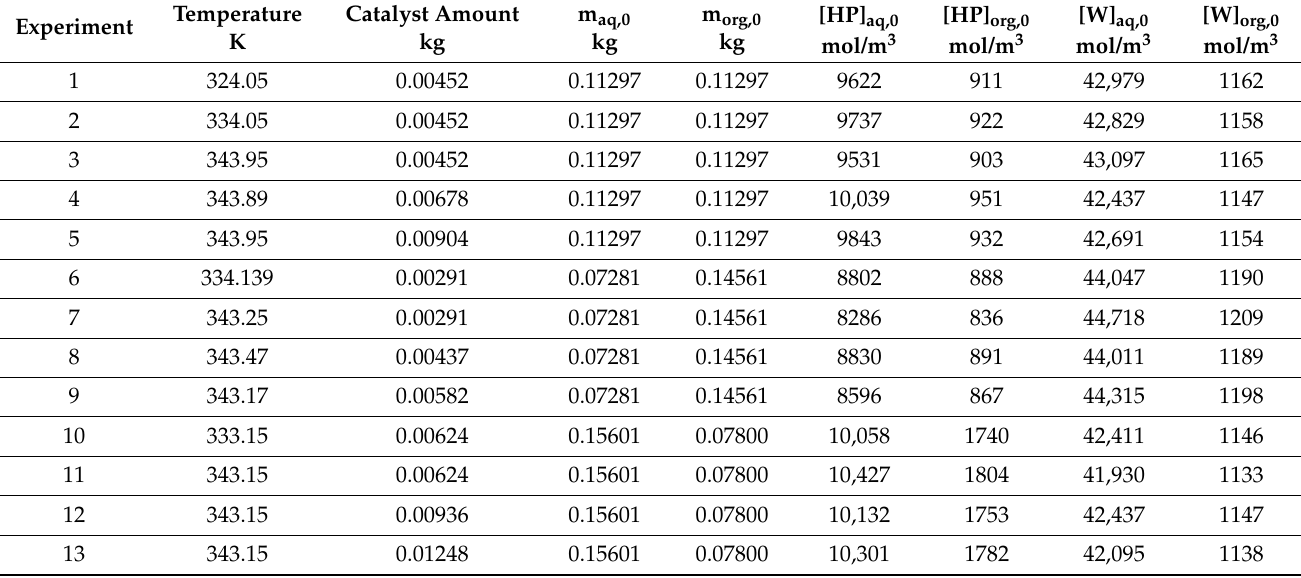
Table 2. Experimental matrix for heterogeneous liquid phase system. HP: hydrogen peroxide; W: water; 0: initial conditions; aq: aqueous phase; org: organic